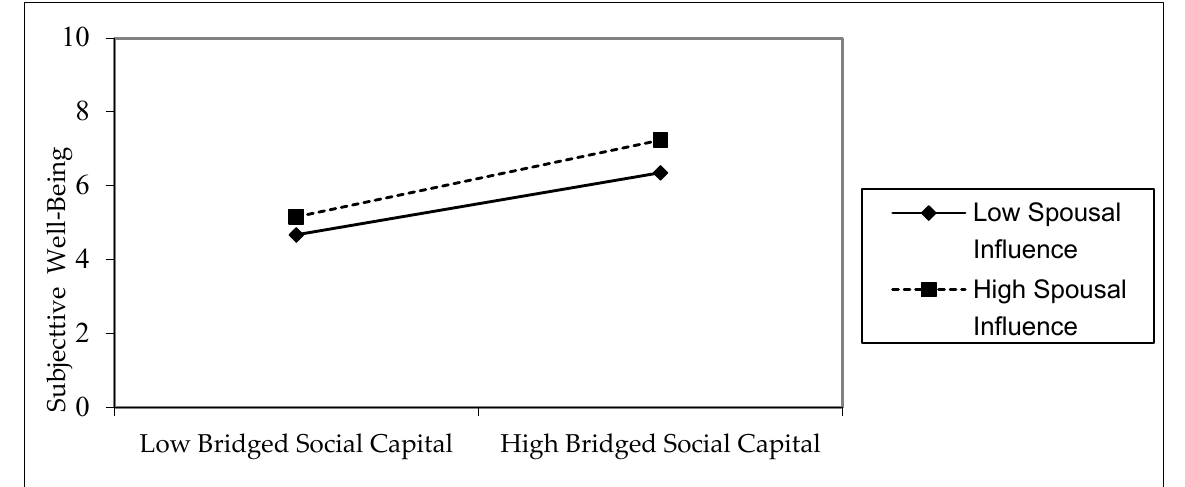
Figure 5. Marital status adjustment of the influence of bridging social capital on the subjective well-being of the elderly.